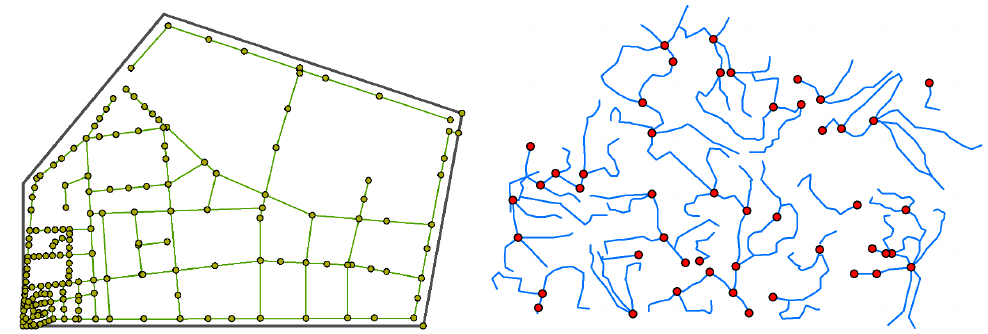
Figure 1. Catch basins and water catchment points.